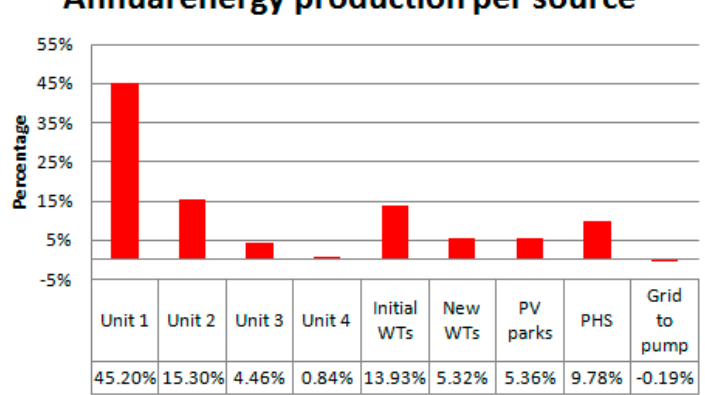
Figure 9. Annual energy production in Samos Island from different sources, considering hybrid power station operation ( P hydro = 3.5 MW).